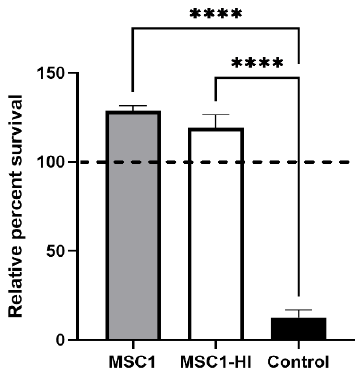
Figure 2. Non-transduced and transduced MSC1 cells survive after exposure to human serum in vitro. MSC1 cells (gray bar), MSC1-HI (white bar), and control cells (PAECs, black bar) were exposed to human AB serum containing antibodies and active complement. Cell survival was assessed by MTT cell viability assay. Cell viability for cells cultured in media only was set to 100% (dashed line) and the relative percent viability was calculated for each cell type. Viability is presented as the mean ± SEM for at least three different experiments. The significance was determined by one-way ANOVA. **** indicates p < 0.0001.